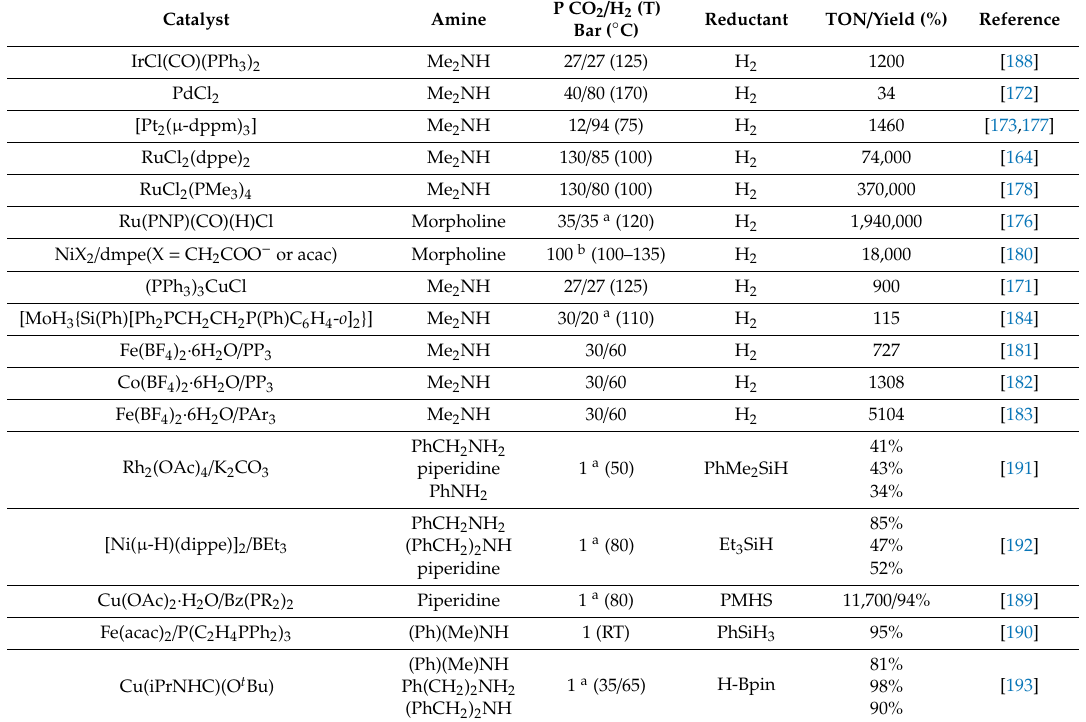
Table 3. A comparison of metal-catalyzed N–H formylation of selected primary and secondary amines with CO 2 . dppm—bis(diphenylphosphino)methane;